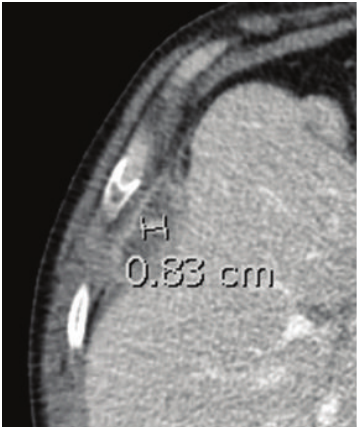
Figure 3: Retained gallstone 5 years following laparoscopic chole- cystectomy visualized with computed tomography with a 1cm radiopaque density within perihepatic fluid